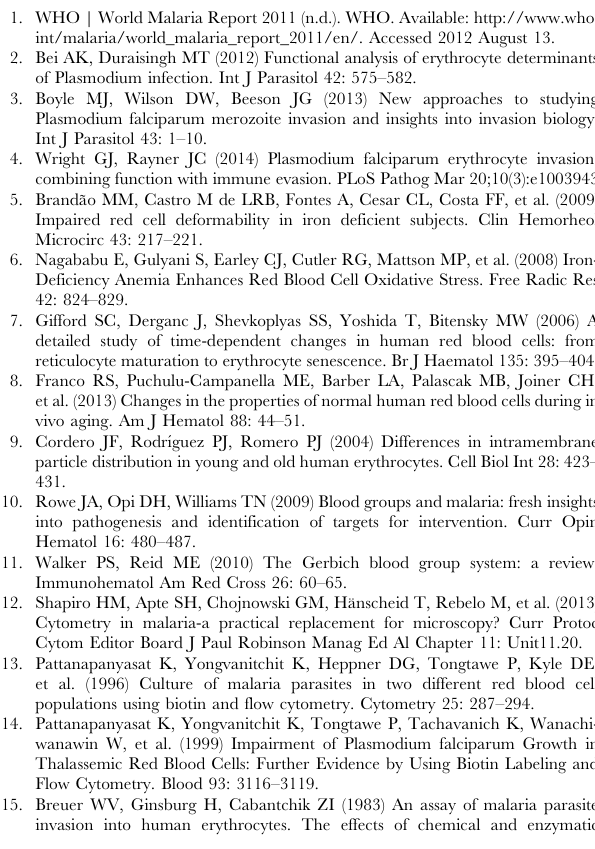
performed in triplicate. (A) Rate of 3D7 and Dd2 invasion into 1:10, 1:1, and 10:1 combinations of RBC Violet and RBC DDAO . Bars represent the mean invasion rate and error bars represent the SD. Elongated triangles below the X-axis represent the replace- ment of RBC Violet (white triangle) with RBC DDAO (gray triangle) in the total RBC population. (B and C) Data shows the number of 3D7 (B) and Dd2 (C) invasion events into RBC Violet (triangles) and RBC DDAO (circles) as the frequency of each RBC type increases from 10% to 90% of the total RBC population. Linear regression was used to determine the best fit line for P. falciparum invasion of RBC Violet and RBC DDAO . ANCOVA was performed to compare the slopes of the lines fit to P. falciparum invasion of RBC Violet and RBC DDAO . The null hypothesis was no difference between RBC Ø and either RBC N , RBC T , or RBC C (H 0 : b Ø = b enzyme , a = 0.05). ANCOVA performed with GraphPad, Prism, v. 5.04, La Jolla, CA calculated a p , 0.0001. and p , 0.06 for 3D7 and Dd2 respectively.